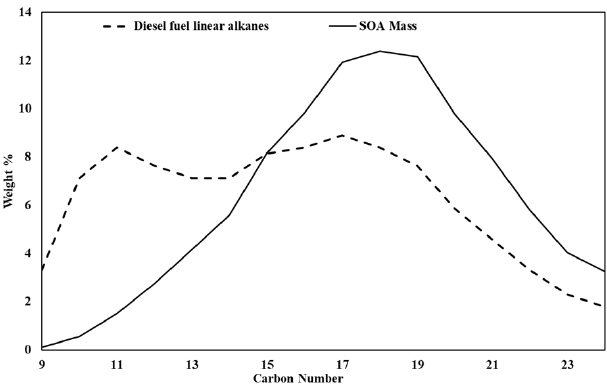
Figure 8. The predicted relative SOA mass formation from the composition of linear alkanes in diesel fuel. The simulation was performed using the CB6-UNIPAR model equipped with IVC- based product distributions. The relative composition of linear alkanes in diesel fuel used is from Gentner et al. (2012). HC ppbC / NO x ppb = 3, RH = 60%, OM 0 = 5µgm − 3